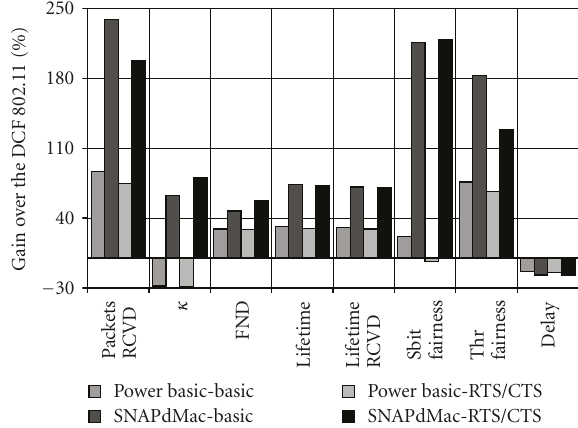
Figure 12: Total number of packets received and throughput— heterogeneous network, Basic access scheme.